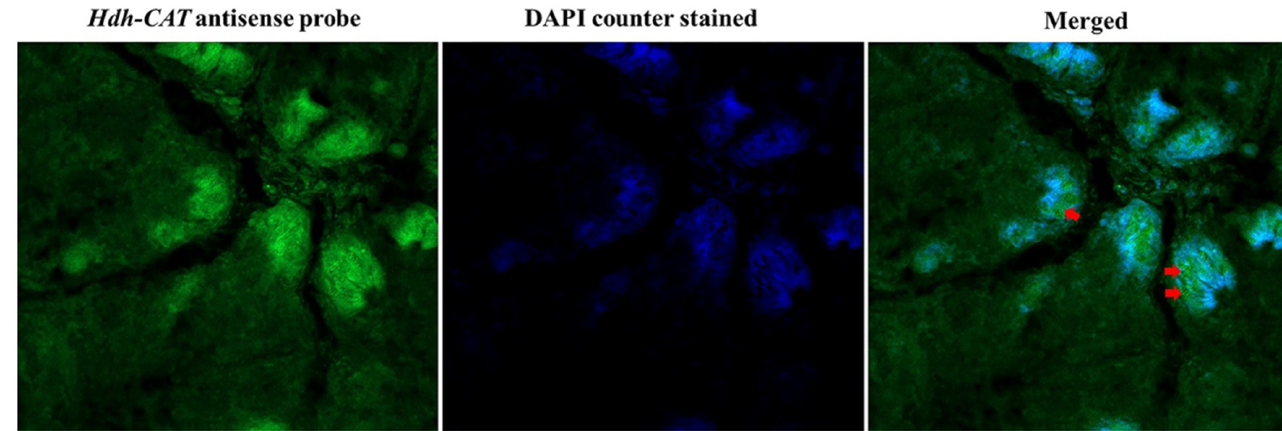
Figure 2. Confocal laser scanning microscopic observation after fluorescence in situ hybridization of Hdh-CAT mRNA in digestive gland tissue of Pacific abalone. The positive signals of Hdh-CAT mRNA were indicated using arrows. Scale bar: 50 μ m.